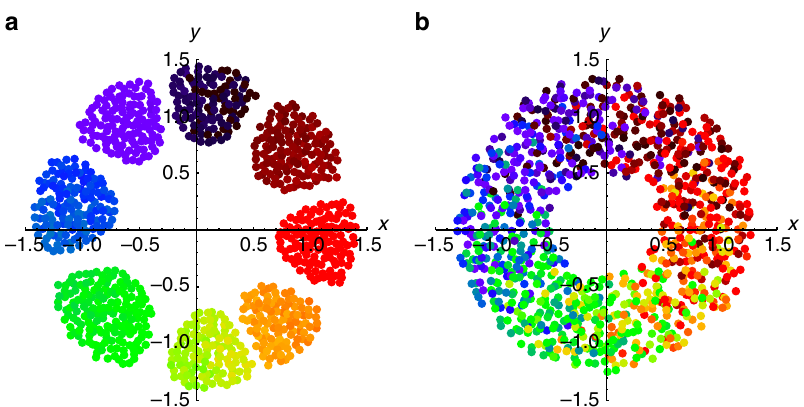
Fig. 5 Non-stationary states. Simulation were run for N = 1000 swarmalators for T = 1000 time units and stepsize dt = 0.1. In all cases, swarmalators were initially placed in a box of length 2 uniformly at random, while their phases were drawn from [ − π , π ]. a Splintered phase wave ( J , K ) = (1, − 0.1). Note, there is a long transient until this state is achieved. See Supplementary Movie 4. b Active phase wave ( J , K ) = (1, − 0.75). See Supplementary Movie 5